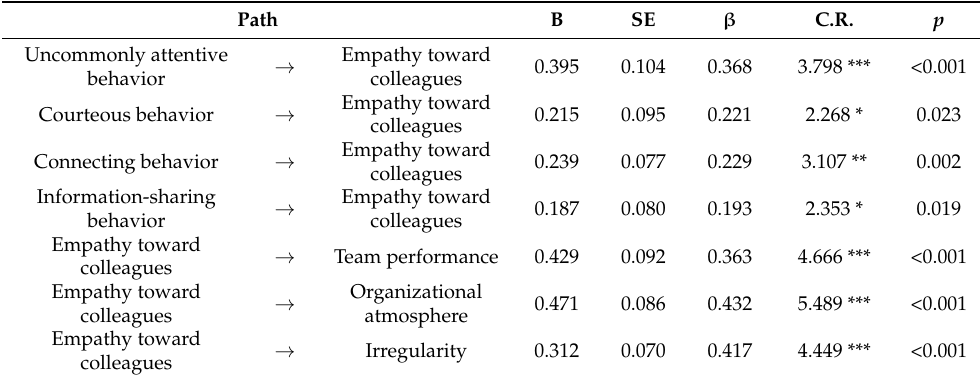
Table 7. Results of the SEM analysis.